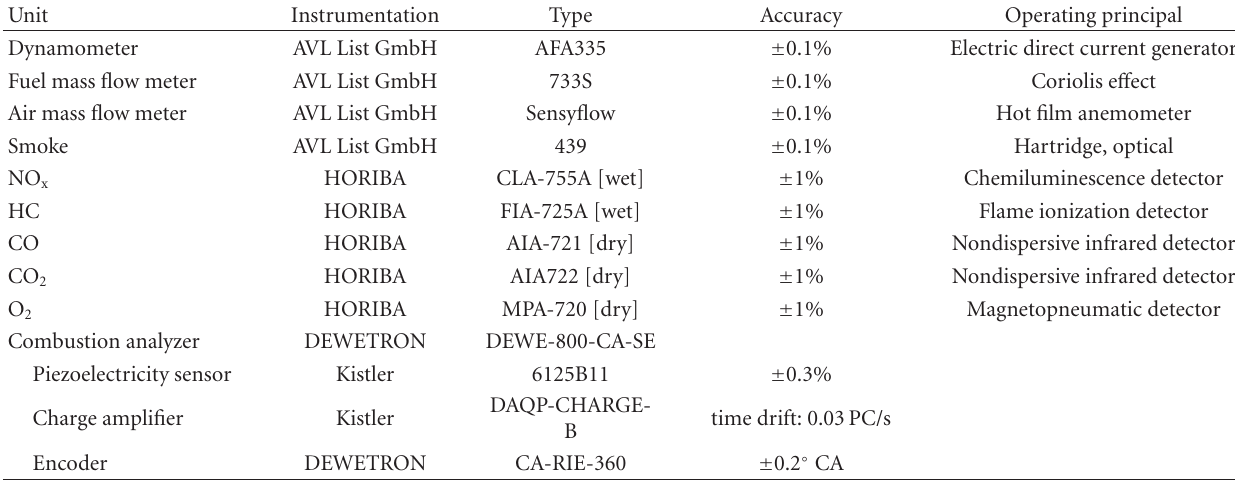
Table 2: Basic instrumentation for pollutant emissions measurements.